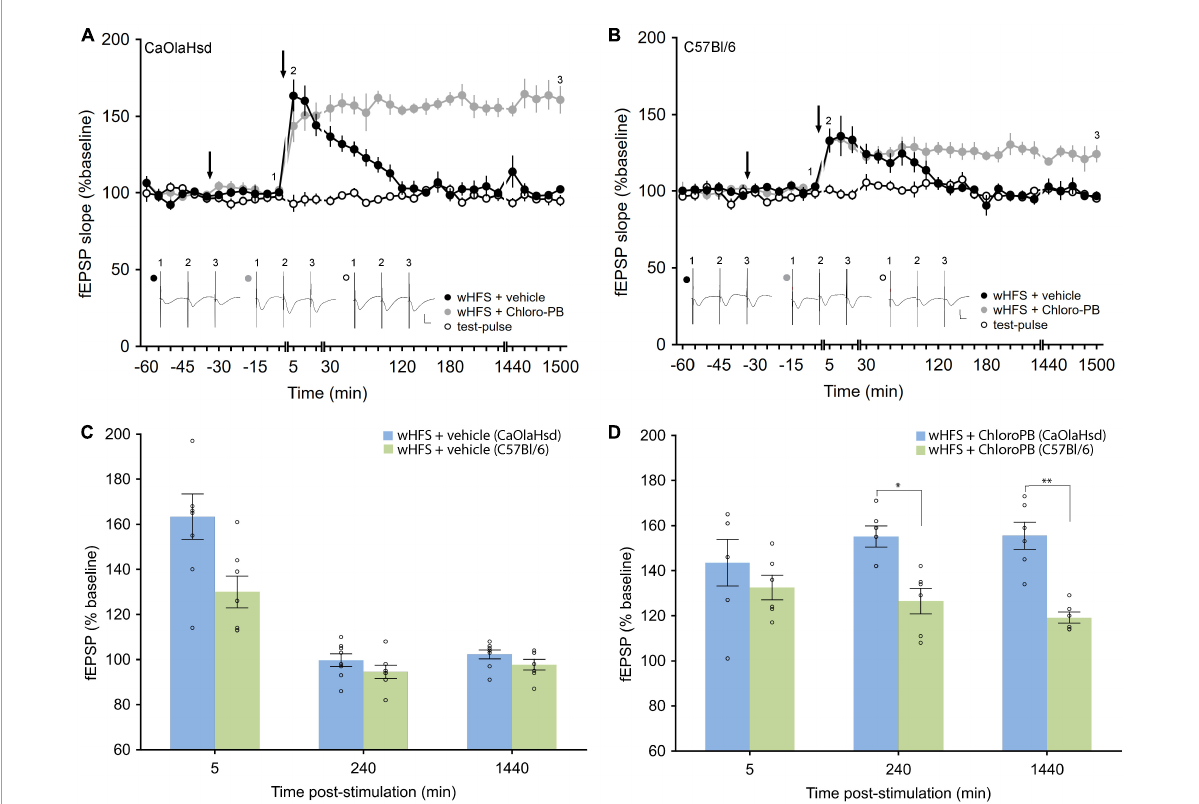
FIGURE4 Effect of the D1/5 receptor agonist Chloro-PB on LTP in CaOlaHsd and C57Bl/6 mice. (A) Weak high frequency stimulation (wHFS, second arrow) results in STP in CaOlaHsd mice (solid black circles) that was significant compared to baseline (test-pulse only) responses for 2 h after wHFS (open black circles). Treatment with the D1/D5 receptor agonist Chloro-PB 30 (first arrow), results in a facilitation of LTP (solid gray circles). Inset shows analog traces recorded at the time points indicated by the numbers in the graph. Line breaks indicate change in time-scale. Vertical scale bar corresponds to 2 mV and horizontal scale bar corresponds to 10 ms. (B) Stimulation of the SC-CA1 pathway with wHFS (second arrow) resulted in an initially smaller STP in C57Bl/6 mice (solid black circles) (compared to CaOlaHsd mice) that was nonetheless significantly different compared to test-pulse stimulation (open black circles) . Treatment with the D1/D5 receptor agonist Chloro-PB (first arrow) , resulted in a facilitation of LTP (solid gray circles) . Inset shows analog traces recorded at the time points indicated by the numbers in the graph. Line breaks indicate change in time-scale. Vertical scale bar corresponds to 2 mV and horizontal scale bar corresponds to 10 ms. (C,D) Bar charts display the difference in evoked responses between CaOlaHsd (blue) and C57Bl/6 mice (green) at different time-points after stimulation in STP control experiments (C) and after injection of Chloro-PB (D) . Open circles represent single data-points. Significant values are denoted by asterisks: ∗ p < 0.05, ** p <